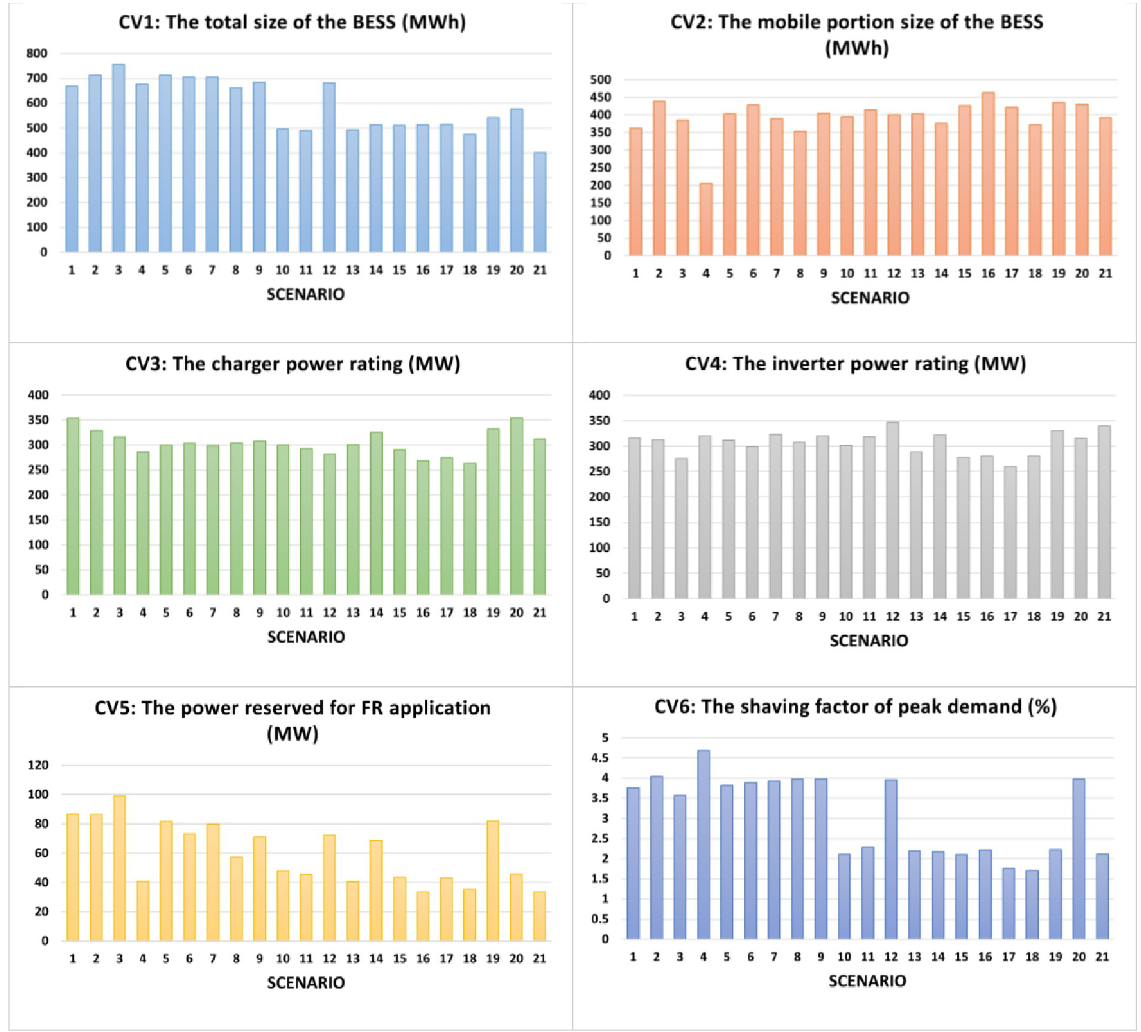
Fig 11. Optimal solutions of the six control variables with 21 weight factors from 0 (Scenario 1) to 1 (Scenario 21) in step of 0.05 under DC priority mode.